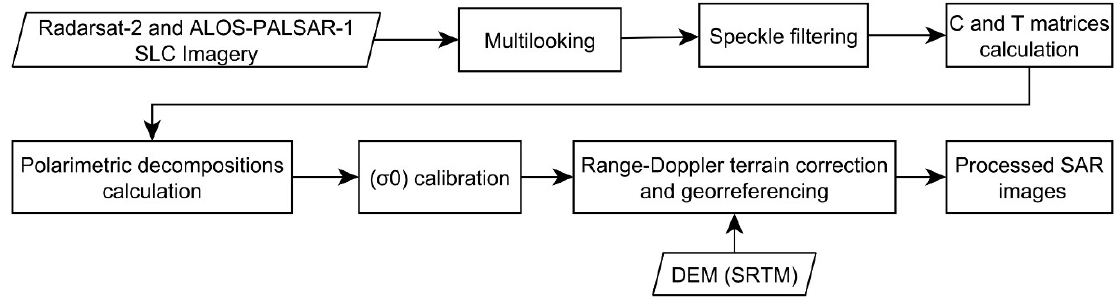
Figure 3. Full polarimetric image processing. Table 2. Polarimetric Features extracted from the full-polarimetric SAR data (quad-pol).